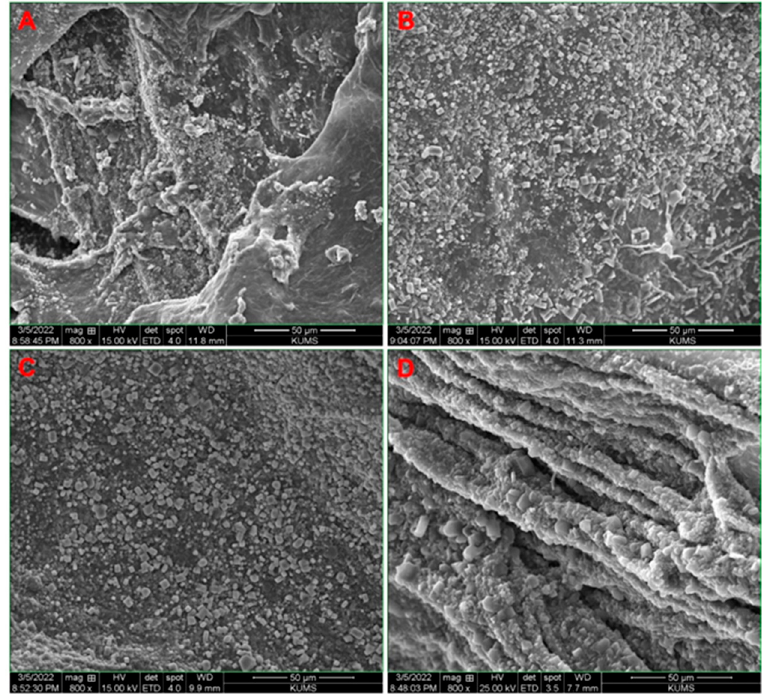
Figure 8. SEM graphs of SBF-submerged substrates showing apatite nanocrystals deposits on ( A ) Alg/BG, ( B ) Alg/Sr-BG 5%, ( C ) Alg/Sr-BG 10%, and ( D ) Alg/Sr-BG 15% after soaking in SBF for 7 days.